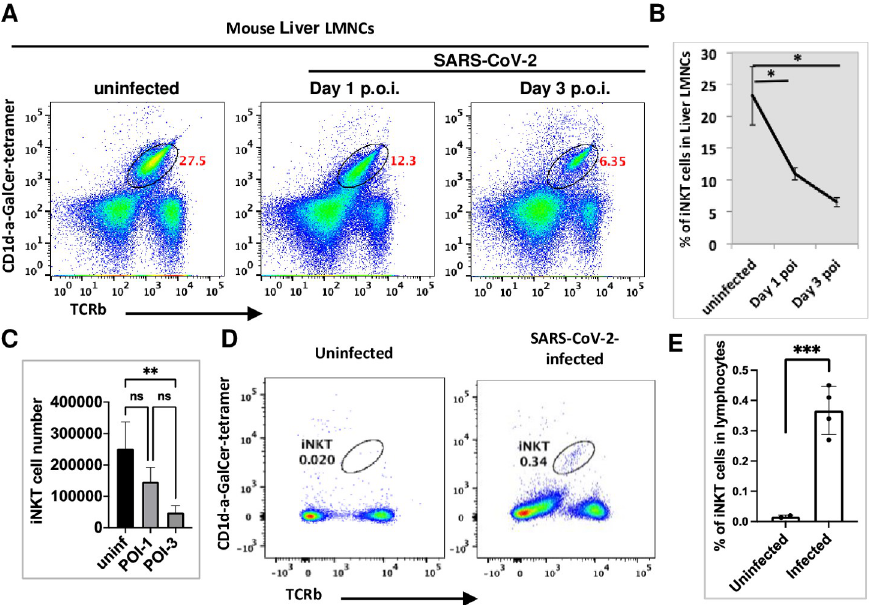
K18-hACE2-Tg mice (n = 3) were infected with SARS-CoV-2 (Isolate USA-WA1/2020) at 1X10e4 pfu/mouse intranasally. Liver mononuclear cells (LMNCs) were stained with α -GalCer-loaded mouse CD1d tetramer for iNKT cells at 1 or 3 days post-infection. The percentage and total numbers of iNKT cells in LMNCs were plotted over the infection course (B, C). (D, E). Single cells were prepared from SARS-CoV-2-infected mouse lungs and stained